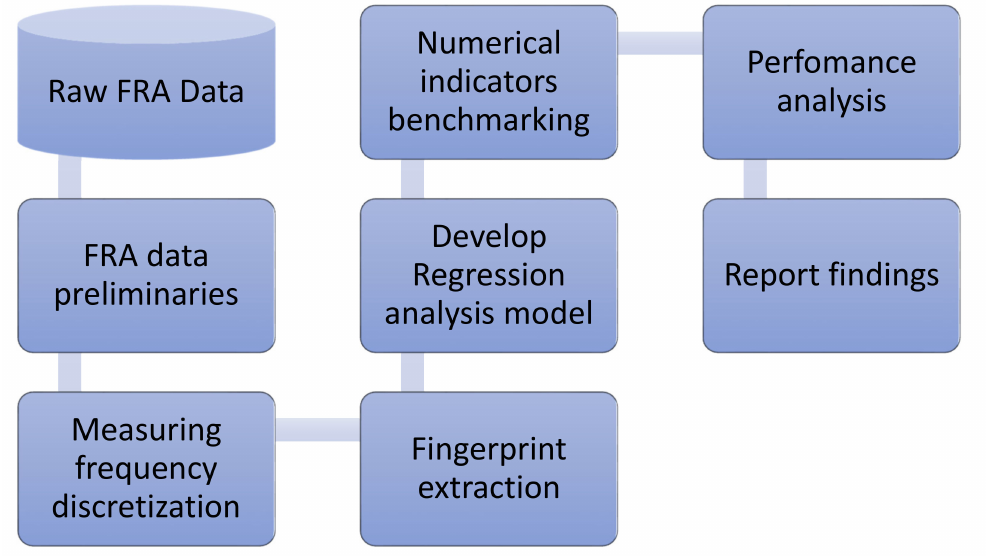
Figure 2. Flowchart for regression analysis fault detection scheme, FRA—Fault Recognition